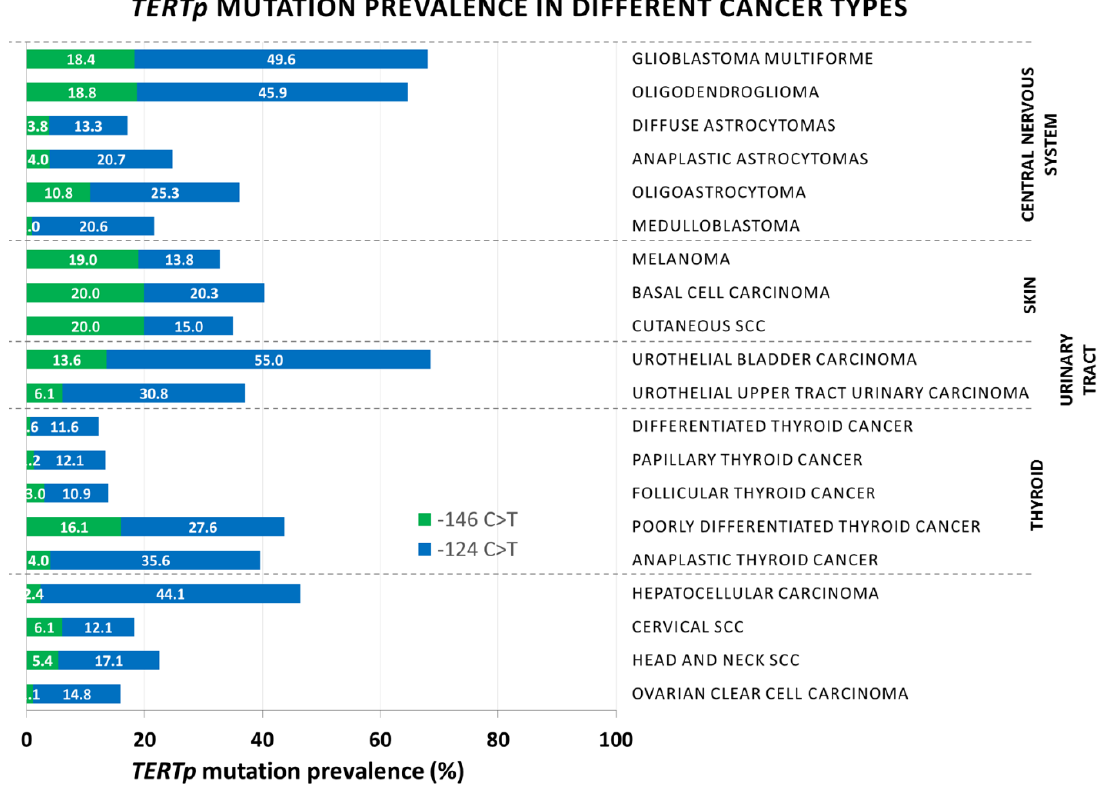
Figure 2. Distribution of TERT promoter mutations in different cancers.